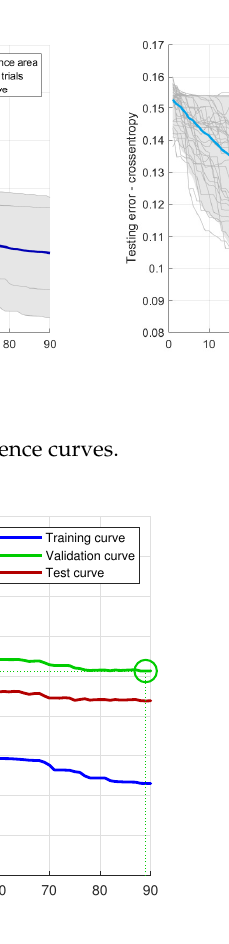
Figure 10. Performance evolution of the best neural network obtained from the 25 independent trials.